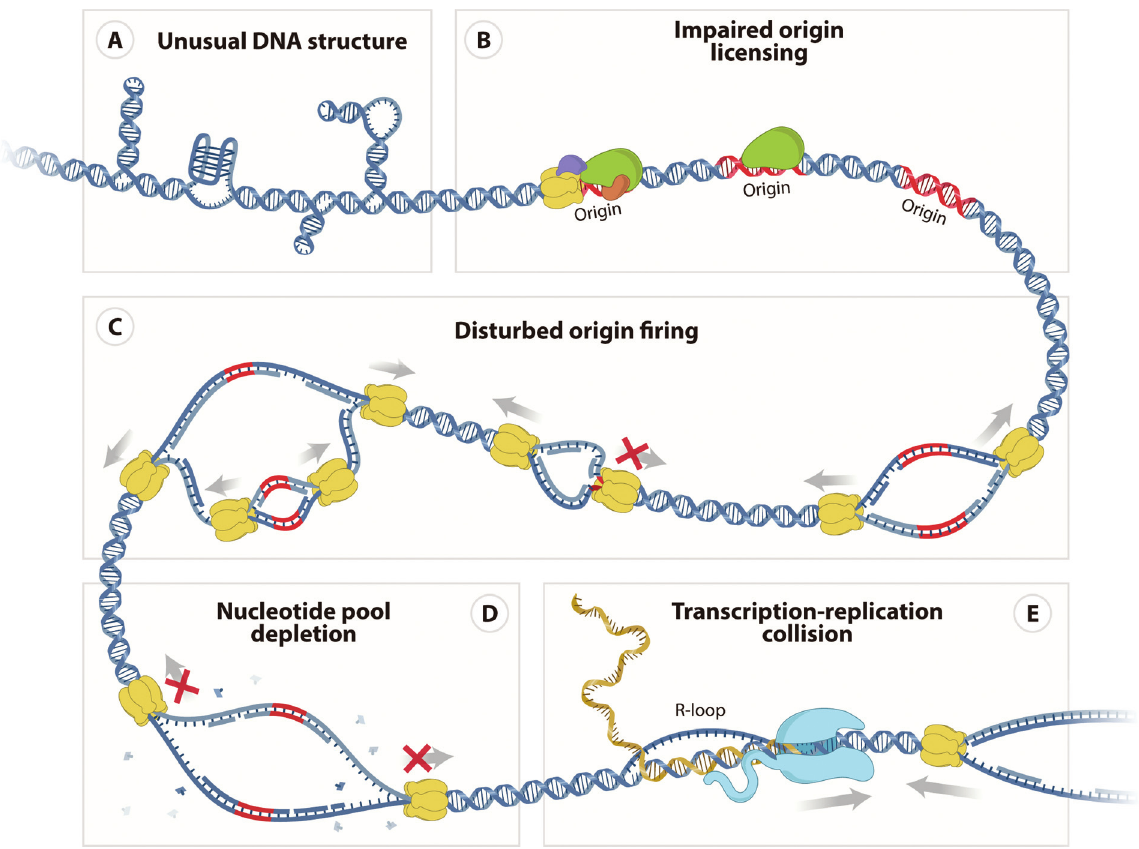
Figure 1 - Molecular mechanisms of DNA replication stress. A) Unusual DNA secondary structures may be formed at certain genomic regions, such as centromeres, telomeres, and fragile sites, and represent natural obstacles to replication fork progression. Stem-loop (left and right) and G-quadruplex (middle) structures are represented. B) Impaired origin licensing may compromise the formation of active replication origins and DNA replication. Nor- mal (left), impaired (middle), and absence of (right) pre-RC formation are represented. C) Disturbed origin firing may interfere with DNA replication and replication fork progression. Normal (right), asymmetric (middle), and repetitive (left) origin firing are represented. D) Uncontrolled S phase entry in the presence of nucleotide pool depletion may impair DNA replication and prevent replication fork progression. E) Collisions between replication and tran- scription machineries may impair DNA replication fork progression through generation of DNA topological stress and formation of persistent R-loops, RNA-DNA hybrid molecules. A-E) DNA molecule (blue strand), DNA origin of replication (Origin, red strand), ORC complex (green), CDC6 protein (orange), CDT1 protein (purple), MCM complex (yellow), RNA polymerase (blue), and messenger RNA (yellow strand) are represented. DNA polymerases and replisomes are omitted for simplicity. Grey arrows represent progression of replication or transcription machineries and red crosses rep- resent stalled replication